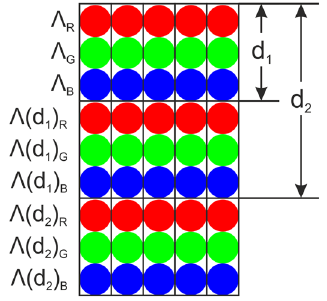
Figure 7. Developed strategy to obtain homogenous white structural colour, by mixing the diffracted blue, red and green wavelengths.